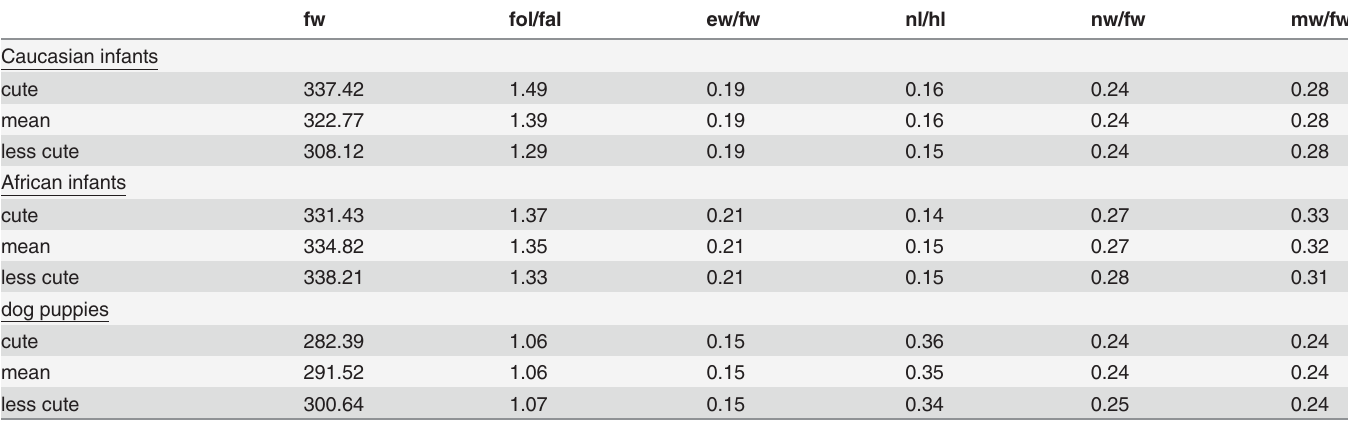
Table 4. Objective measures of baby schema (cf. Glocker et al.